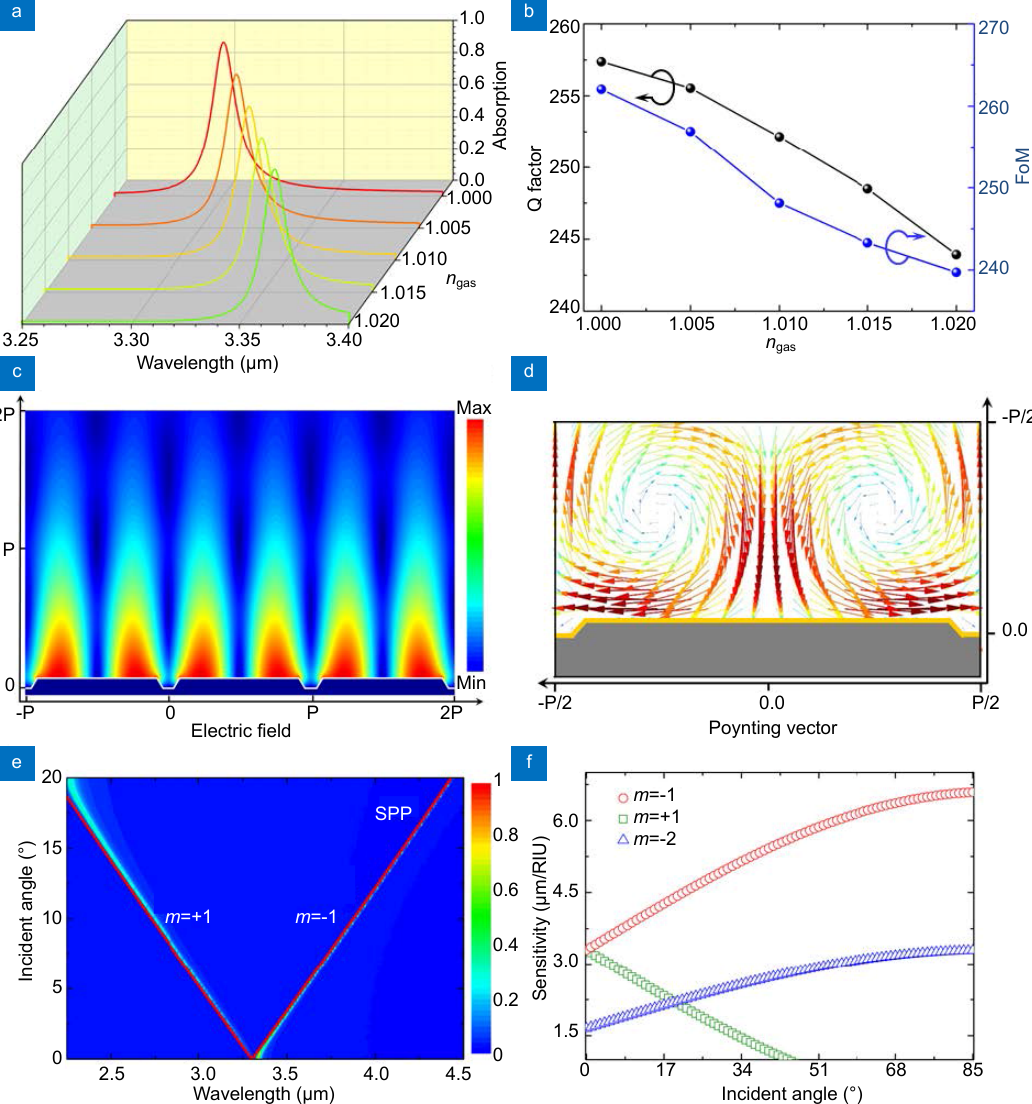
Fig. 2 | ( a ) Simulated absorption spectra at different n gas for the device structure in Fig. 1(a). The period of gratings P = 3.3 µm, the grating depth h g = 160 nm, and the grating width w g = ( w 1 + w 2 )/2 = 3 µm. ( b ) Q factor and FoM at various n gas . ( c ) The electric field distribution at the resonance peak ( λ = 3.3 μ m) at n gas = 1. ( d ) Poynting vector at the resonance. ( e ) The calculated absorption spectra as functions of wavelength and incident angle. ( f ) Sensitivities of different order modes versus the